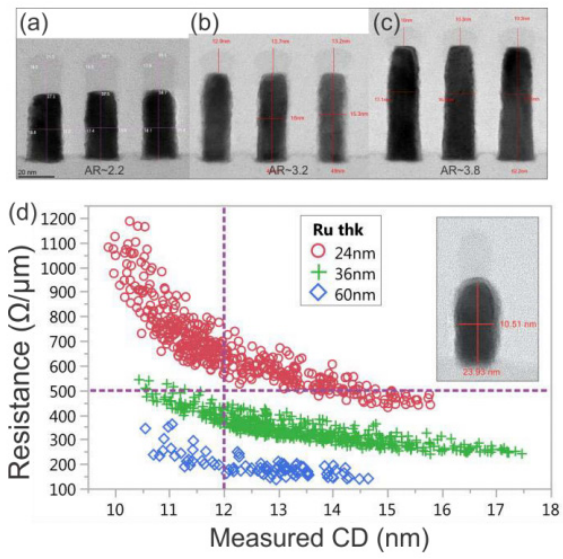
Figure 11. Cross-sectional TEM of patterned Ru films with a thickness of ( a ) 24 nm, ( b ) 36 nm, and ( c ) 60 nm. ( d ) Corresponding R vs. CD for all structures on each wafer. Reprinted/adapted with permission from Ref. [85]. 2018, IEEE.